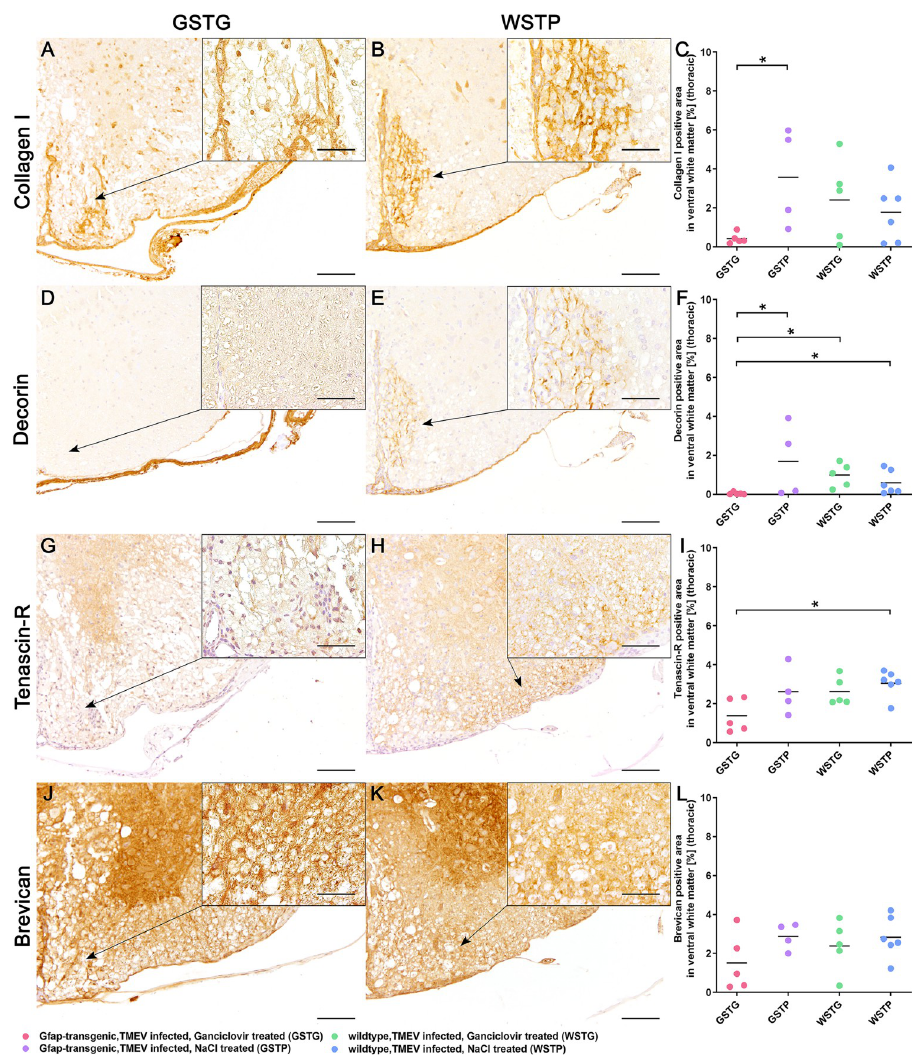
Fig 6. Impact of astrocyte depletion upon non-basement membrane extracellular matrix (ECM) components. Identification and quantification of basement ECM accumulation in the thoracic spinal cord white matter was performed using immunohistochemistry identifying collagen I ( A-C ), decorin ( D-F ), tenascin-R ( G-I ), and brevican ( J-L ). Statistical analysis revealed a significant reduction of collagen I in the ventral part of the thoracic spinal cord white matter in TMEV infected, ganciclovir treated, GFAP-transgenic (GSTG) mice ( A ) compared to TMEV infected, NaCl treated, GFAP-transgenic (GSTP) controls ( C ). Immunohistochemistry detecting decorin showed a significant decrease of decorin positive area in astrocyte depleted animals compared to their controls ( F ). Inserts visualize in more detail the increased intralesional accumulation of collagen I ( B ) and decorin ( E ) in WSTP control animals compared to astrocyte depleted mice ( A , D ). Furthermore, tenascin-R was significantly reduced in GSTG mice compared to TMEV infected, NaCl treated, wildtype (WSTP) controls ( I ). Loss of tenascin-R in GSTG animals was intralesionally observed in the thoracic spinal cord white matter as indicated by the arrow in G , whereas control animals showed a diffuse circumferential expression of tenascin-R as visualized in H and in more detail in the inserts ( G , H ). However, immunohistochemistry targeting brevican did not reveal a significant difference between GSTG mice ( J ) and the control animals ( K, L ), as shown also in higher magnification in the inserts ( J , K ). For each antibody, one cross section of the thoracic spinal cord was evaluated per animal. Data are shown as scatter dot plots. The horizontal bar indicates the mean. Significant differences between GSTG and the control groups obtained by Kruskal-Wallis test followed by Mann–Whitney U post hoc tests are indicated by � , p � 0.05. Bars represent 100 μ m in overviews and 50 μ m in the